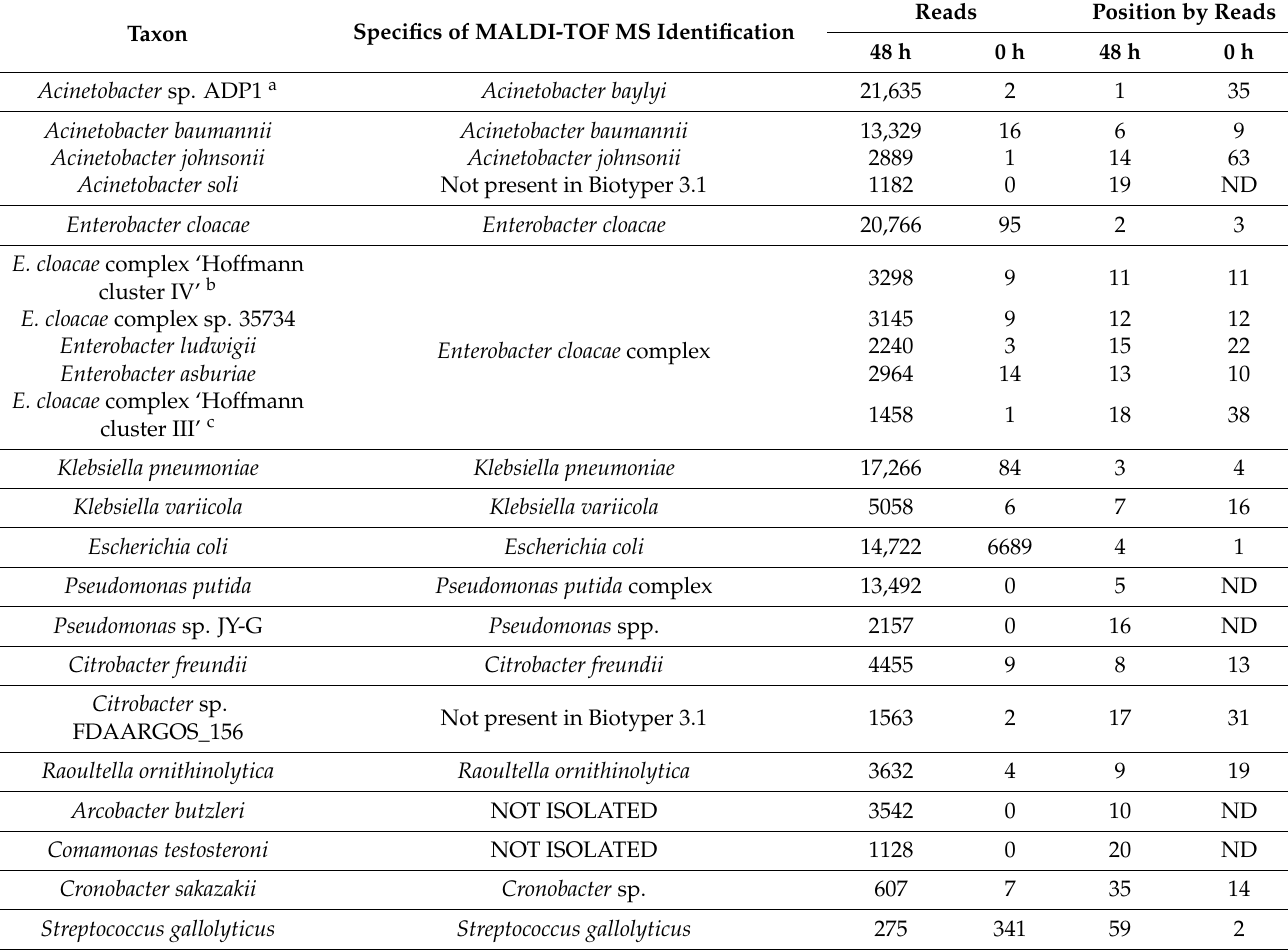
Table 5. Sample A: Comparison of MinION and MALDI-TOF MS, a — Acinetobacter baylyi ADP1 [44], b — Enterobacter roggenkampii , c — Enterobacter hormaechei subsp. hoffmannii [45], ND—not